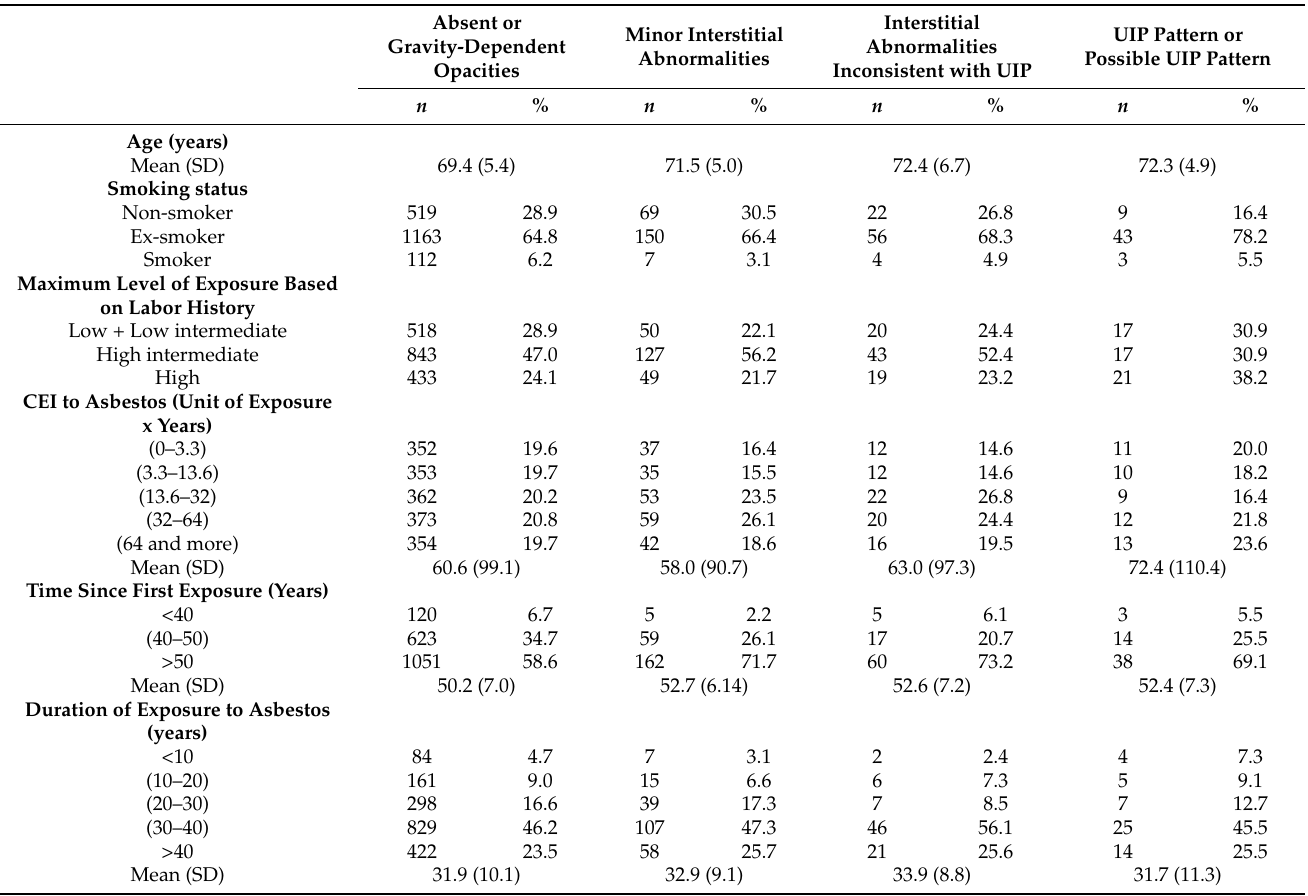
Table 2. Frequency of interstitial abnormalities detected at CT according to demographic characteristics, smoking status and asbestos exposure